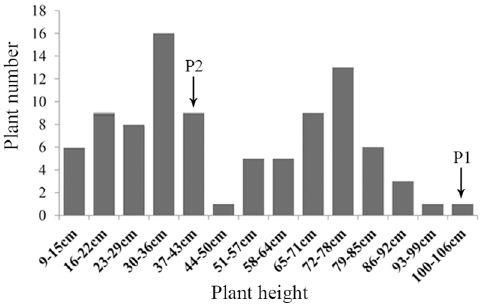
Fig 8. Frequency distribution of plant height in the BC 1 population and the parent lines. P1 represents the female parent (non-dwarf seedling in the F 1 population) and P2 represents the male parent ( L . indica ‘ Pocomoke ’